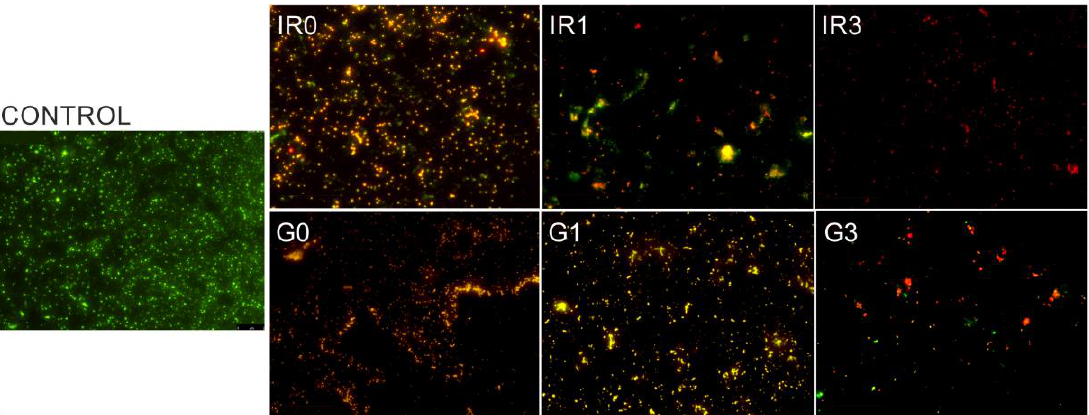
Figure 10. Bacterial adhesion. Images taken with the fluorescence microscope of mixed oral bacteria after 90 min of incubation. Control sample is the bare titanium disc without Ag-NPs. The other samples correspond to Ti discs with immobilized Ag-NPs obtained according to conditions of Table 3.